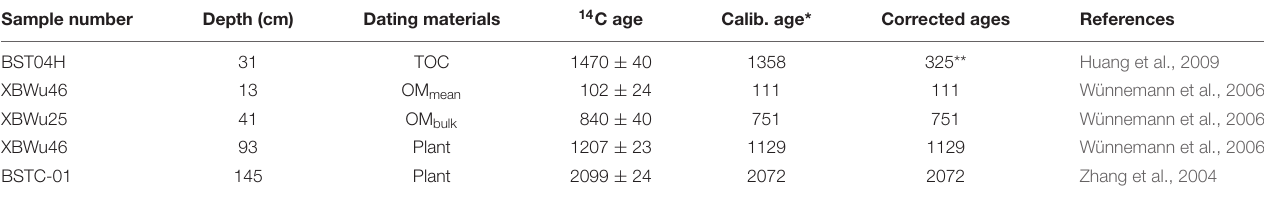
TABLE 3 | 14 C ages of sediments in Lake Bosten from some previous